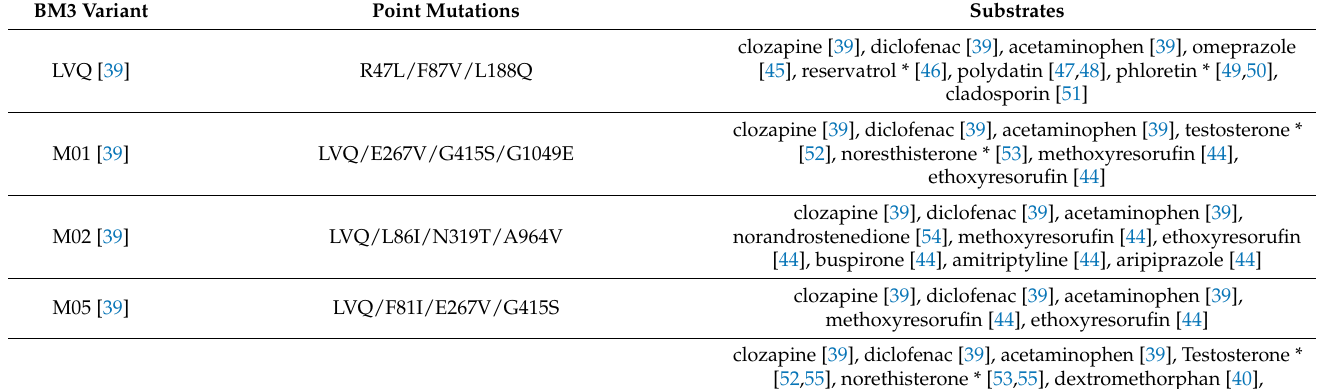
Table 1. Promiscuous BM3 variants and their corresponding drug substrates. Asterisks indicate where further point mutations were introduced for metabolism. BM3